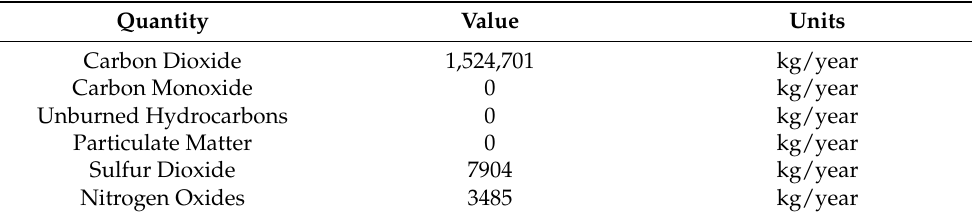
Table 8. Greenhouse gas emission of the developed